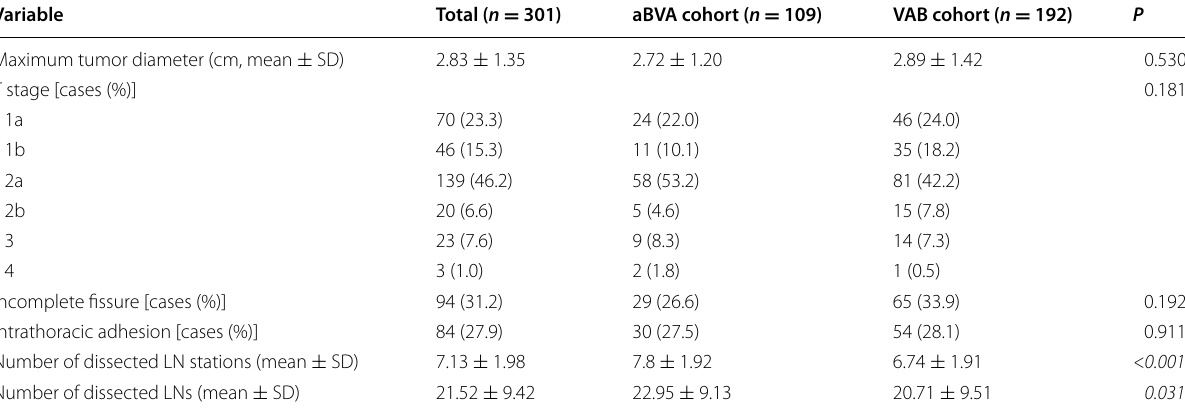
Table 2 Comparison of characteristics related to surgical difficulties between the aBVA and VAB cohorts